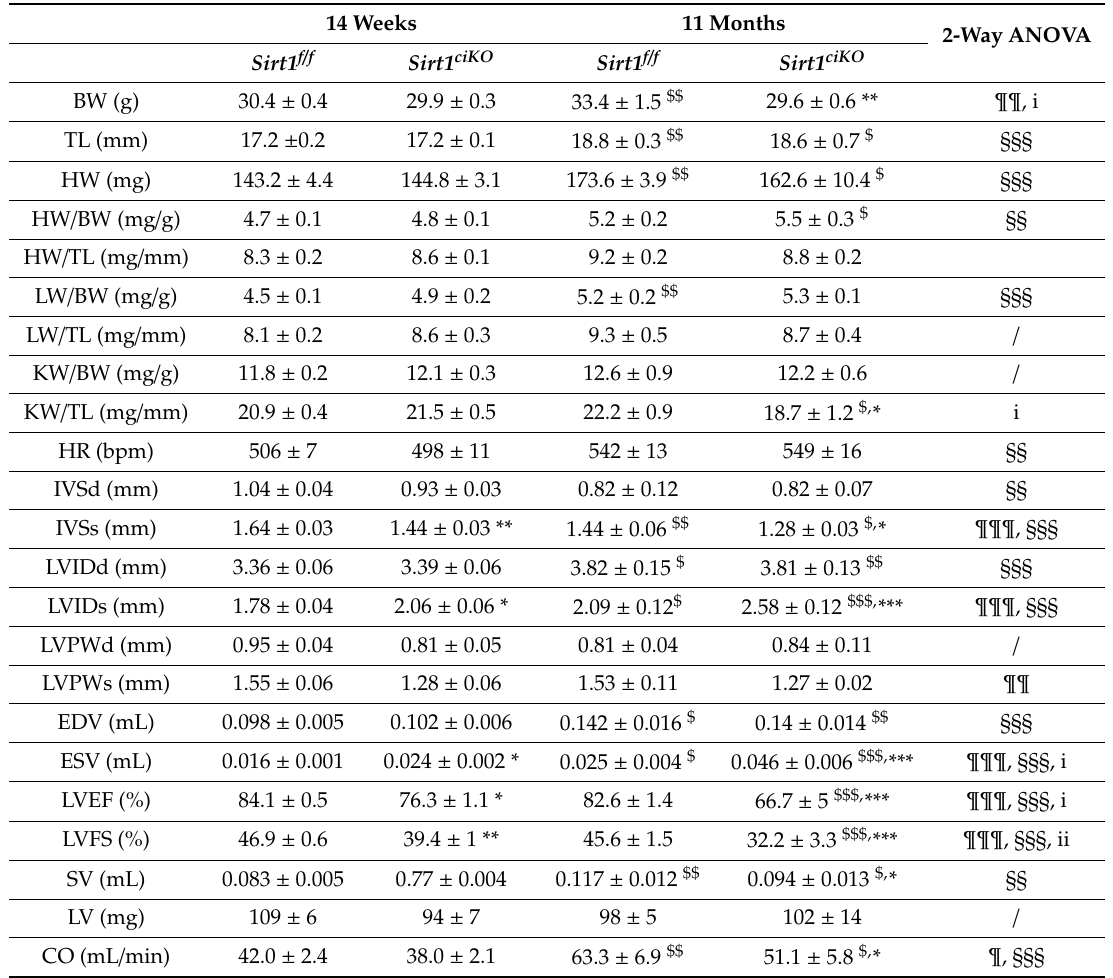
Table 1. Anatomical and echocardiographic parameters 14 weeks and 11 months after induction of Sirt1 deletion by tamoxifen injection. BW, Body weight. TL, Tibia length. HW, Heart weight. HW / BW, Heart weight-to-body weight ratio. HW / TL, Heart weight-to-tibia length ratio. LW / BW, Lung weight-to-body weight ratio. LW / TL, Lung weight-to-tibia length ratio. KW / BW, Kidney weight-to-body weight ratio. KW / TL, Kidney weight-to-tibia length ratio. HR, Heart rate. IVSd, Interventricular septal thickness at end-diastole. IVSs, Interventricular septal thickness at end-systole. LVIDd, Left ventricular internal dimension at end-diastole. LVIDs, Left ventricular internal dimension at end-systole. LVWPd, Left ventricular posterior wall thickness at end-diastole. LVWPs, Left ventricular posterior wall thickness at end-systole. EDV, Left ventricular telediastolic volume. ESV, Left ventricular telesystolic volume. LVEF, Left ventricular ejection fraction. LVFS, Left ventricular fractional shortening. SV, Stroke volume. LV, left ventricular mass. CO, Cardiac output. ANOVA: ¶ p ≤ 0.05, ¶¶ p ≤ 0.01, ¶¶¶ p ≤ 0.001 for the genotype e ff ect; § p ≤ 0.05, §§ p ≤ 0.01, §§§ p ≤ 0.001 for the aging e ff ect; i p ≤ 0.05, ii p ≤ 0.01 for the interaction e ff ect. Post hoc Newman–Keuls test: * p ≤ 0.05, ** p ≤ 0.01, *** p ≤ 0.001 Sirt1 f / f